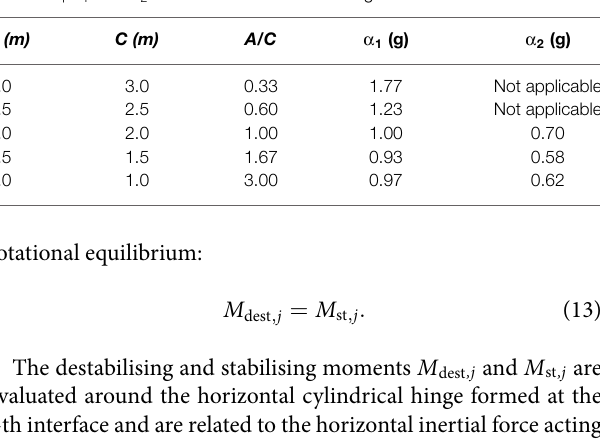
TABLE 2 | α 1 and α 2 values for different wall